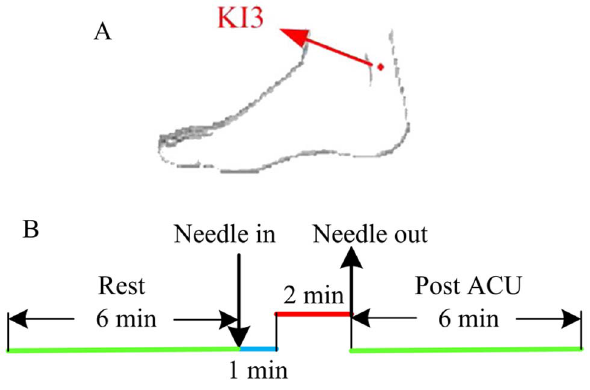
Figure 1. Experimental paradigm. A: The location of the acupoint used in the experiment. B: The paradigm of the experiment: the resting state run lasted for 6 minutes; acupuncture run totally lasted for 9.0